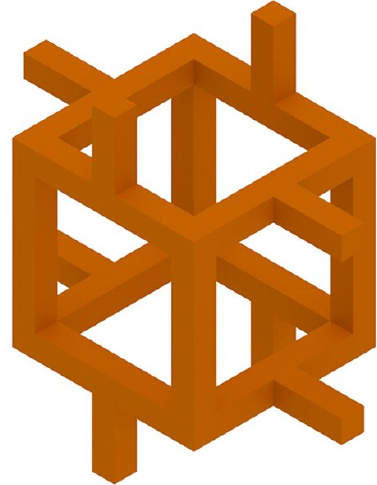
Figure 3. The structural unit cell used in the Ashby and Gibson